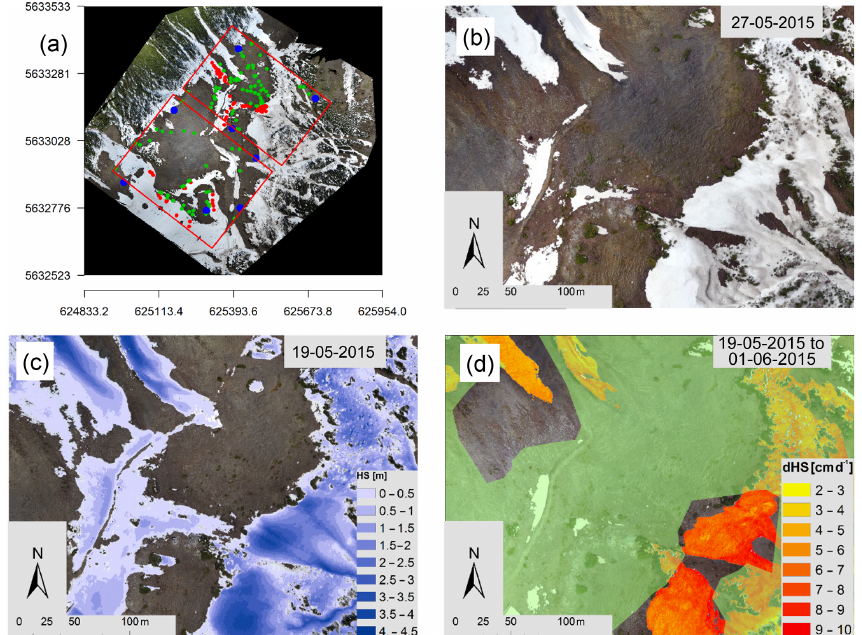
Figure 3. UAV photogrammetric data for the study site. (a) Orthomosaic from images captured on 22 May 2015, showing the two N and S areas of investigation (red polygons); the points indicate the locations of manual snow depth and differential GPS measurements over snow (red) and bare ground (green). The coordinates shown are in UTM zone 11N. Panels (b) , (c) and (d) are enlargements of part of the study area showing evidence of dust on snow, snow depth (HS) on 19 May 2015 and differences in snow depth (dHS) between that date and 1 June, respectively. The green colour in indicates areas excluded from the analysis due to human impacts on the snow or substantive